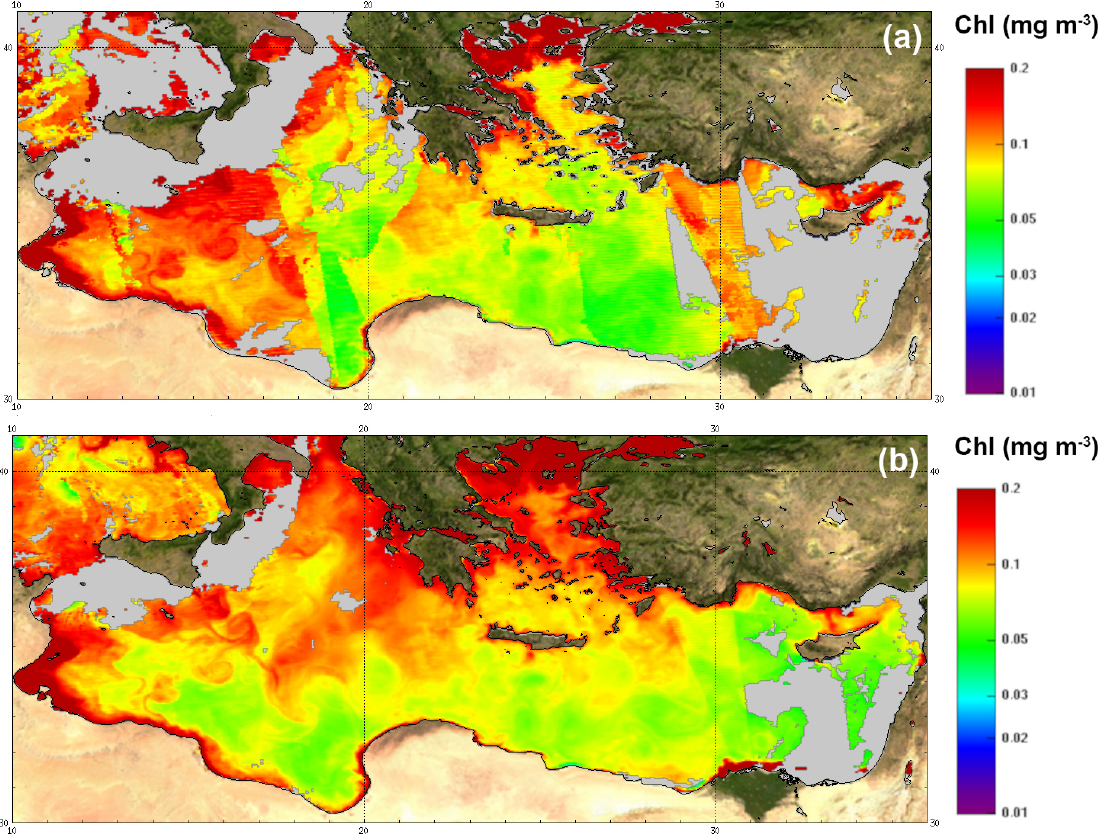
Figure 6. Inter-comparison of the (a) OC-CCI and (b) GlobColour products (13 June 2018) for oligotrophic water (CI algorithm). The colour scale ranges from 0.01 to 0.2mgm − 3 : discontinuities between tracks of the sensor clearly appear at the top of the OC-CCI case.